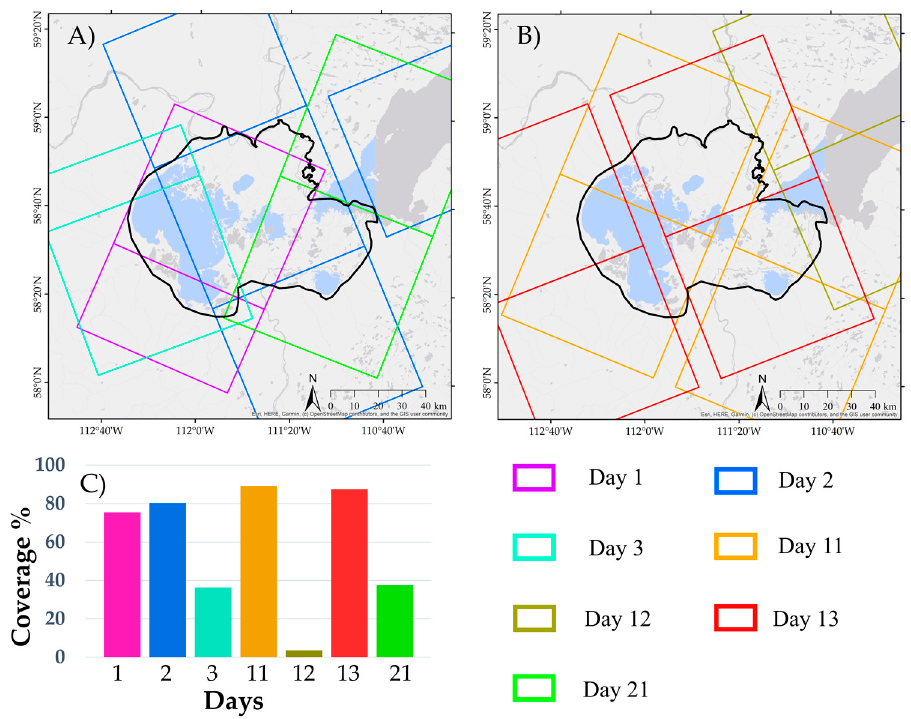
Figure 4. Study period SWOT-LS spatial coverage featured in two groups. ( A ) group A; ( B ) group B; ( C ) coverage percentage.